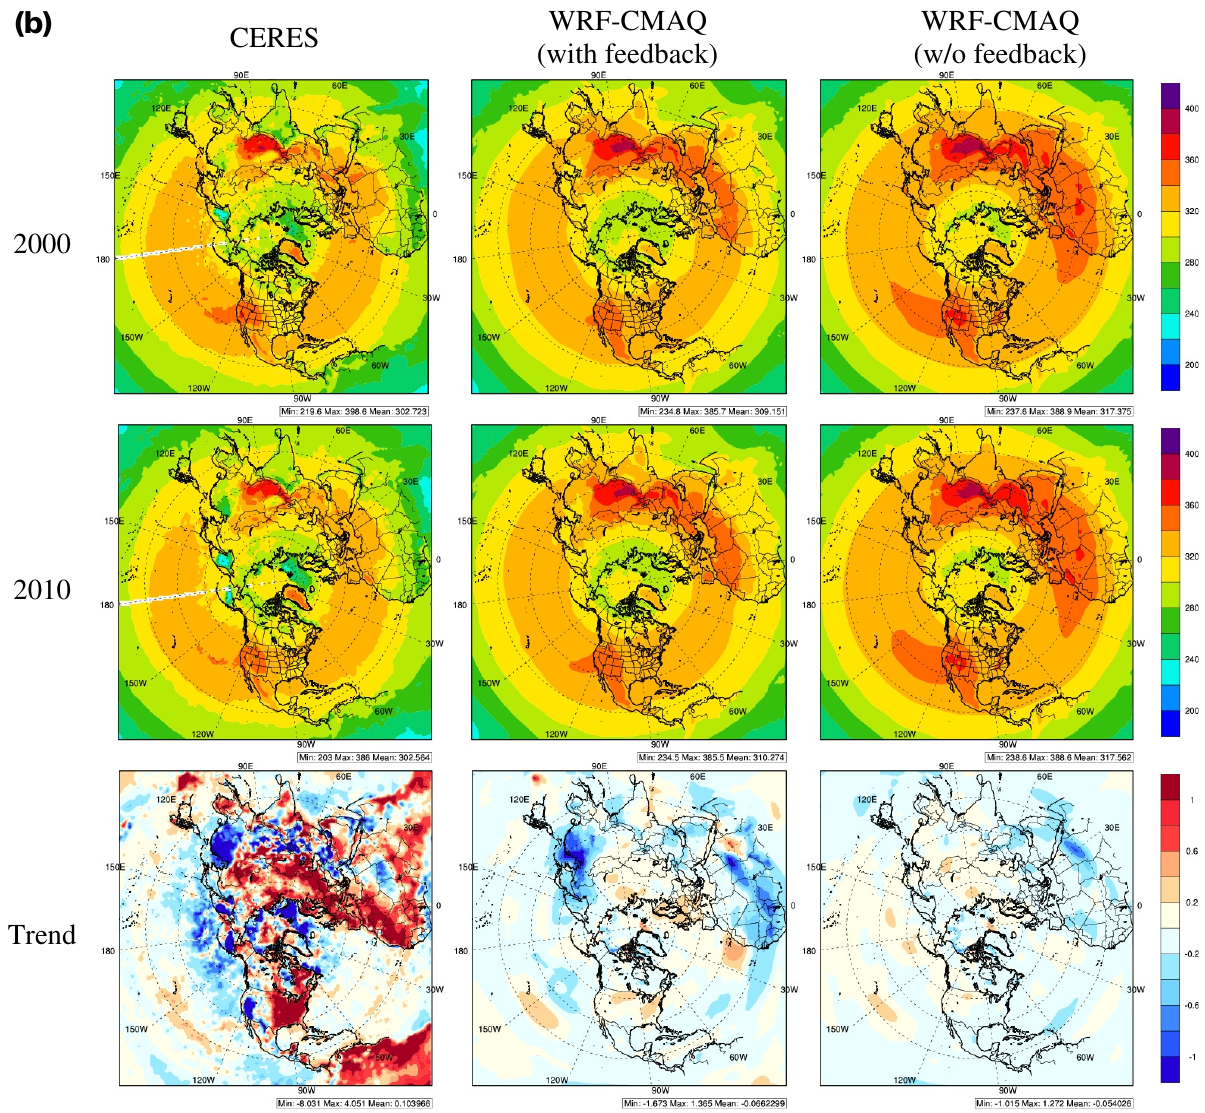
Figure 6. Spatial distribution of summertime clear-sky shortwave radiation (SWR) from the CERES satellite and the WRF-CMAQ model: (a) at TOA (upwelling), and (b) at the surface (downwelling) (unit: Wm − 2 ; trends are computed on the basis of the JJA average over the 2000–2010 period with a linear least square fit